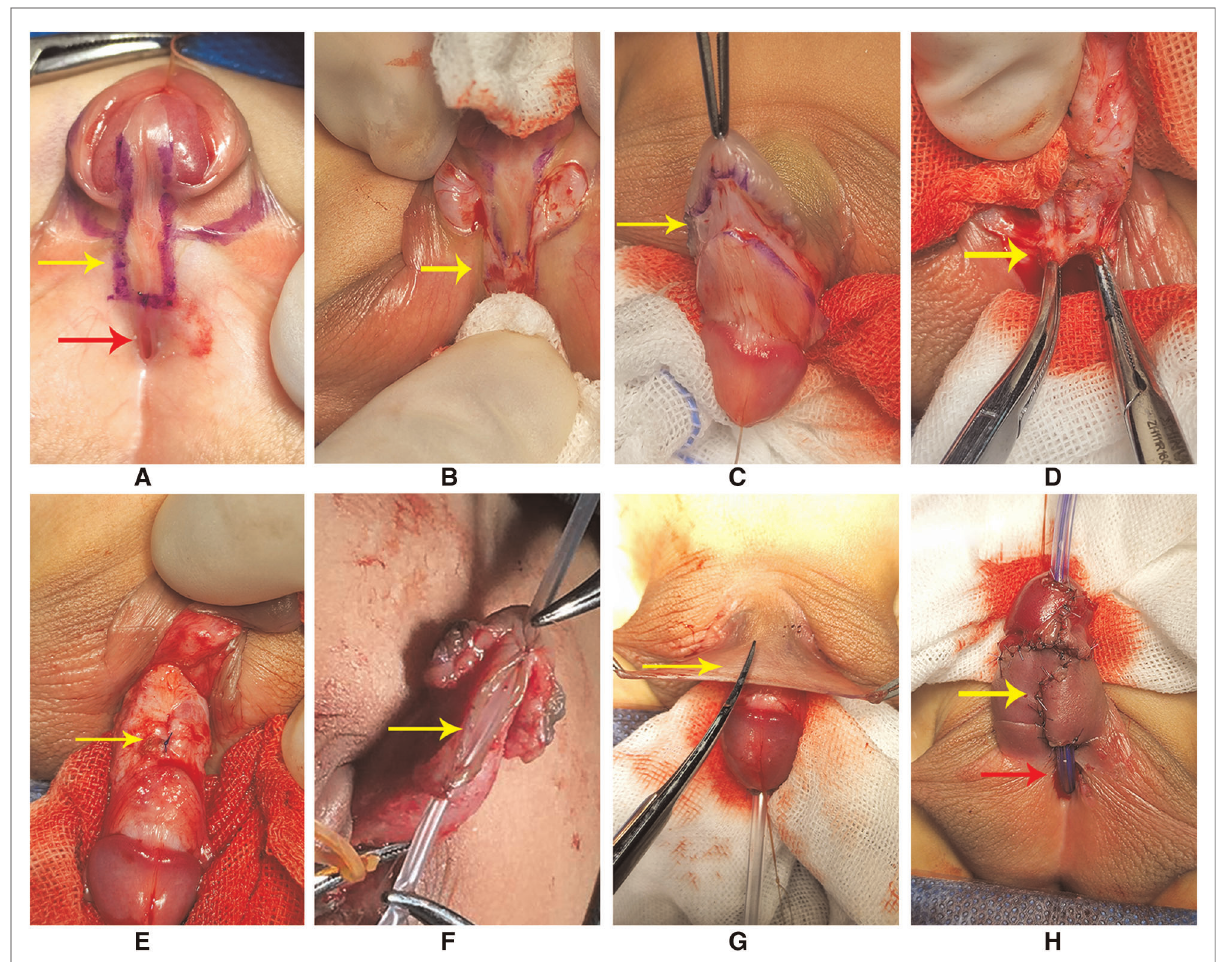
FIGURE 1 ( A ) Designing of the incisions (red arrow: the ectopic urethral ori fi ce). ( B ) Transection of the urethral plate (arrow); a longitudinal parallel incision with a width of about 8 – 10 mm. ( C ) Degloving the penis (arrow). ( D ) Mobilizing the urethral plate along the base of the urethra cavernosum (arrow: proximal urethral plate). ( E ) Dorsal plication was made to straighten the penis (arrow). ( F ) Urethral plate was rolled into a tube with a running suture to form the neourethra. ( G ) Mobilizing and transferring the fl ap to the ventral of the penis to cover the neourethra and corpus cavernosum (arrow). ( H ) Completing the urethroplasty (red arrow: residual urethral defect and the ectopic urethral ori fi ce; yellow arrow: